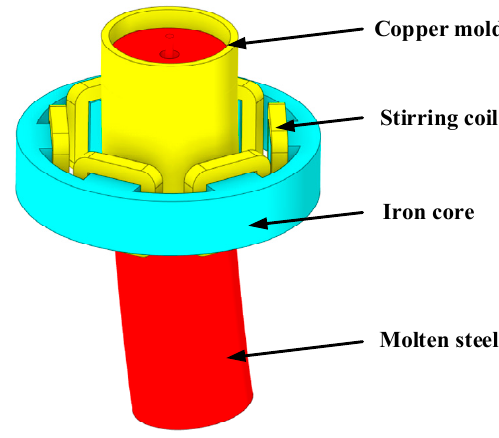
Figure 2. Geometrical model of electromagnetic stirrer. Table 2. Chemical compositions of P91 (wt.%). Table 1. Geometric dimensions of the three kinds of nozzles.